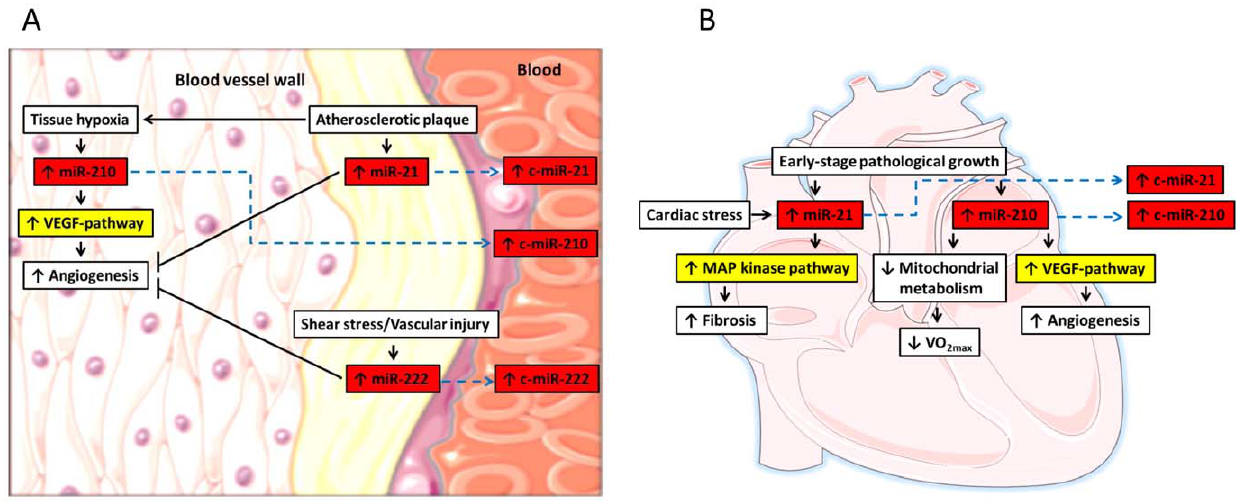
Figure 3. Potentially increased microRNAs and associated pathways in subjects with low maximal oxygen uptake (VO2max). The connections between the biological processes, microRNAs and the regulated pathways in A) the vessel wall and (B) the heart are based on the current knowledge in the literature. Red boxes illustrate the microRNAs that were increased in patients with low VO2max and the yellow boxes depict the associated pathways as identified by miR-Path analyses. Upward arrows inside the boxes illustrate up-regulation and downward arrows illustrate down-regulation. Blue dashed lines indicate the putative release of the microRNAs to the circulation. Pointed arrows illustrate activation and flat arrows illustrate inhibition. c-miR: Circulating microRNA, VEGF: Vascular endothelial growth factor, VO2max: Maximal oxygen uptake.